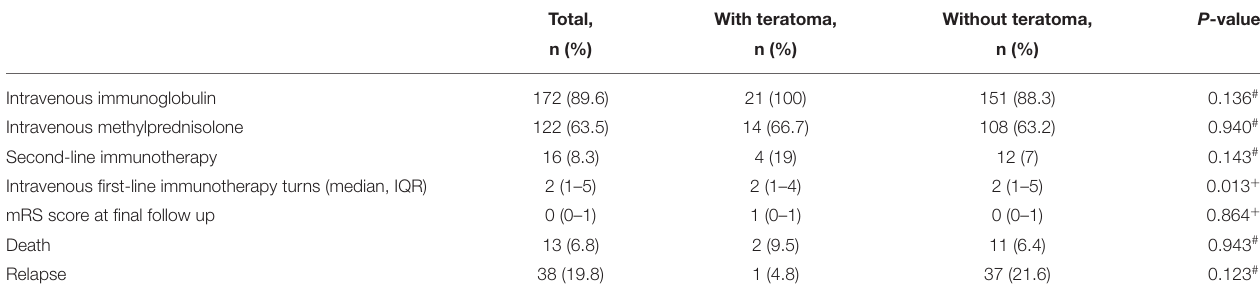
TABLE 4 | Management and outcomes of patients with and without teratoma. Total, With teratoma, Without